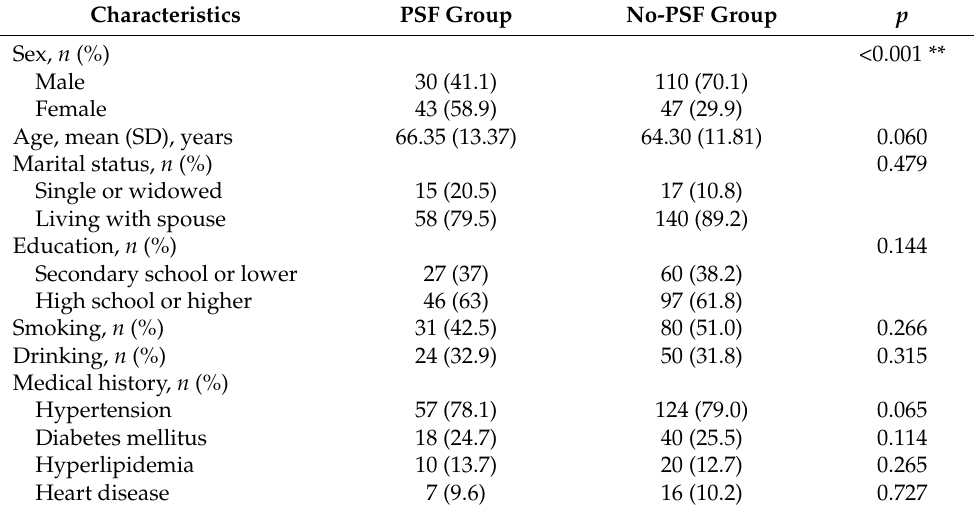
Table 1. Comparison of characteristics between the PSF and no-PSF groups.